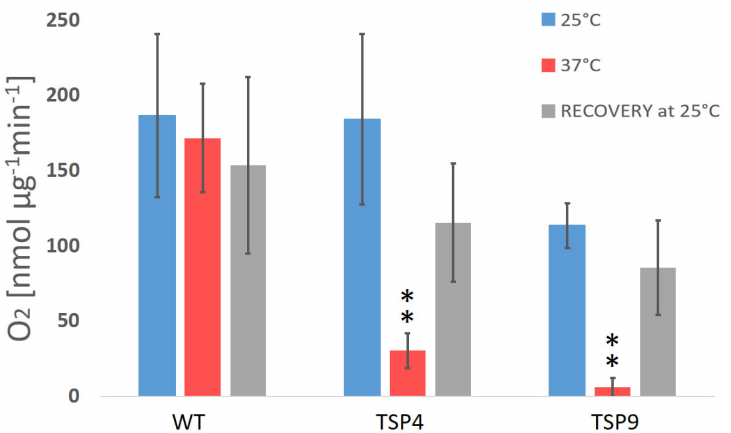
Figure 1. Average rate of O 2 production (in nmol O 2 per µ g chlorophyll for 1 min) in Chlamydomonas reinhardtii wild type and TSP mutant at three temperature conditions (color coded). The oxygen production rates of the wild type (WT), TSP4, and TSP9 mutants were measured at a light intensity of 300 µ E/m 2 s and in the dark and calculated relative to the corresponding chlorophyll levels. Graphs were produced using Excel. Statistical analysis was performed using Graph Pad. The data represent the mean ± standard deviation of five to eight independent experiments, outliers were removed. The significance level by an unpaired t -test for “TSP4 vs. WT” and “TSP9 vs. WT” at 37 ◦ C is indicated as follows: no sign means p > 0.01 and ** means p < 0.001.